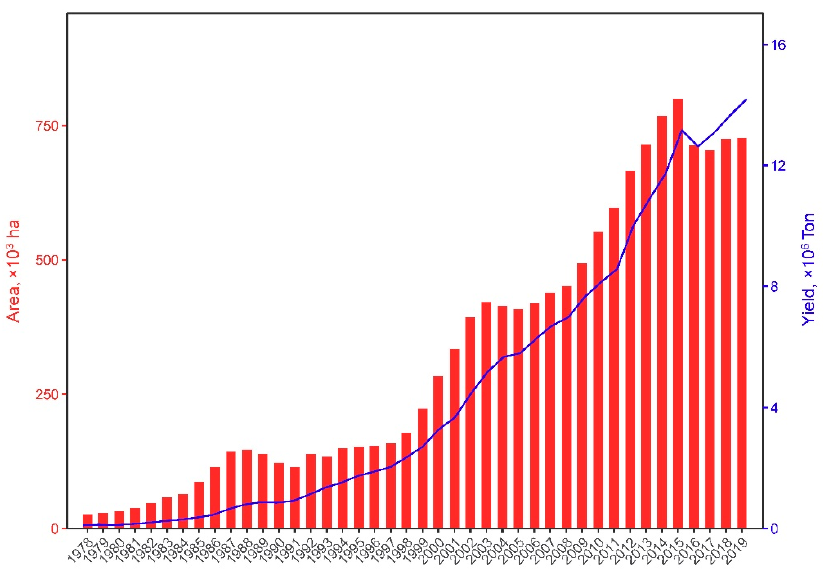
Figure 2. Average annual grape production at the provincial level from 1978 to 2019, China (data from the China Rural Statistical Year Book, 1985–2019, China Statistics).